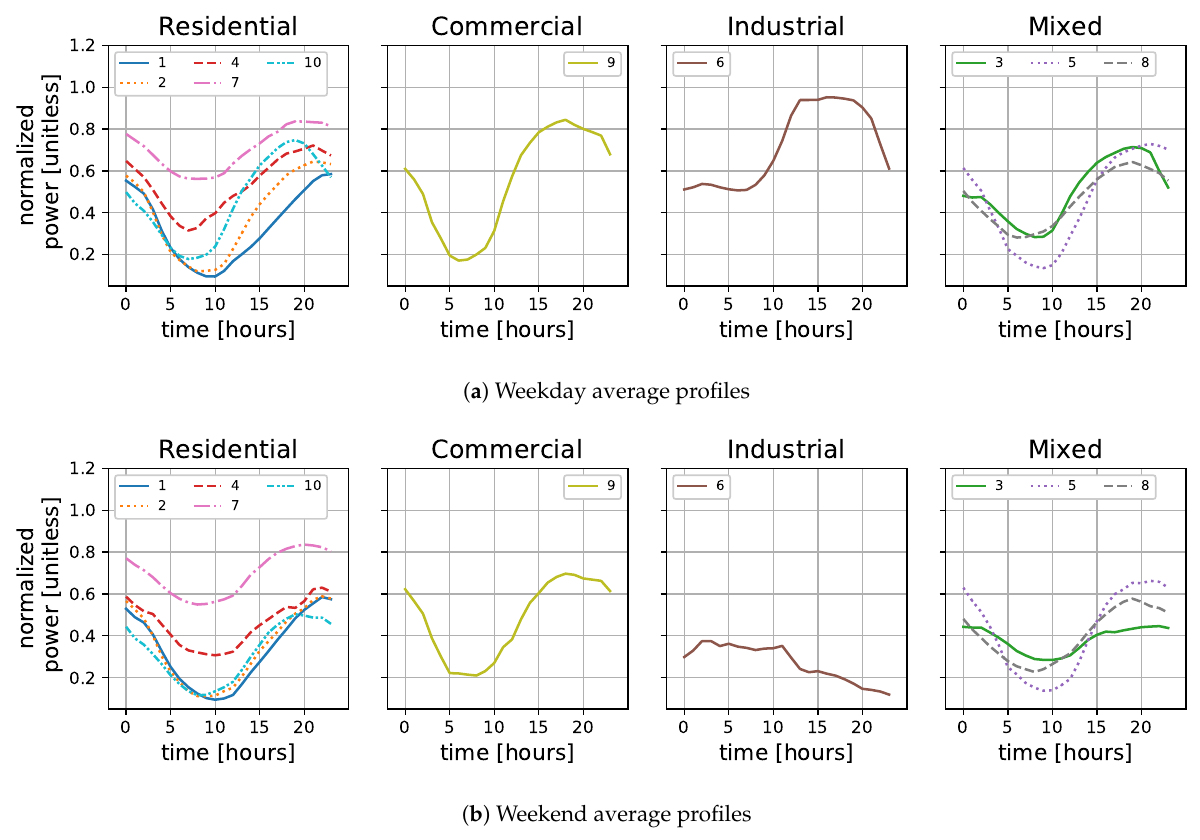
Figure 5. The typical (average) profiles for each feeder during the ( a ) the weekdays and ( b ) weekend days. For each feeder type, the overall demand tended to be smaller on weekend days compared to weekdays. Exceptions included systems that supported mostly residential loads (e.g., Feeder